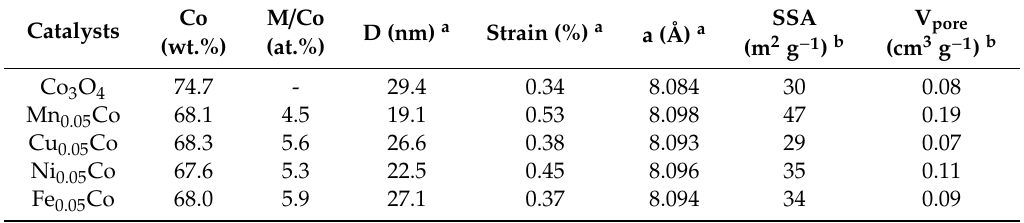
Table 1. Chemical composition, structural, and textural properties of the Co 3 O 4 and M 0.05 Co catalysts.